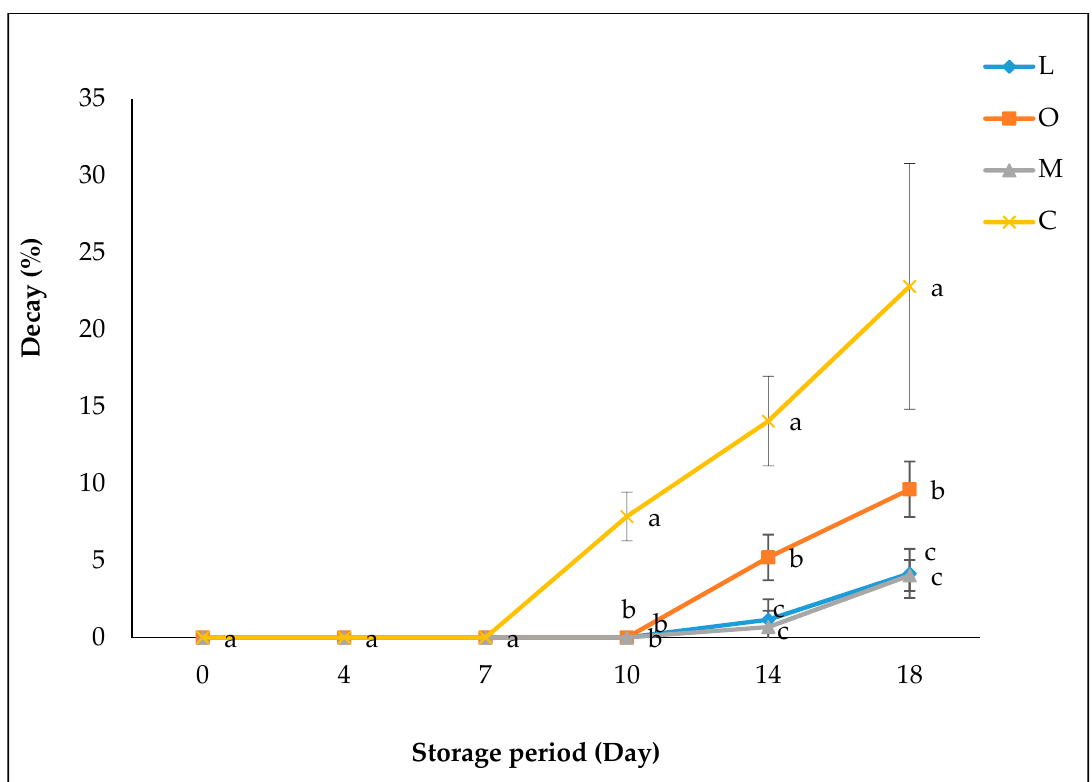
Figure 3. Effect of different essential oil emulsions (L = lemon, O = orange, and M = mandarin essential oil) on decay of strawberry fruits stored at 2 °C for 18 days. Vertical bars indicate the standard deviation (n = 6). Means and different letters indicate significant difference between treated and control fruits at each storage period (Duncan’s of 95%).